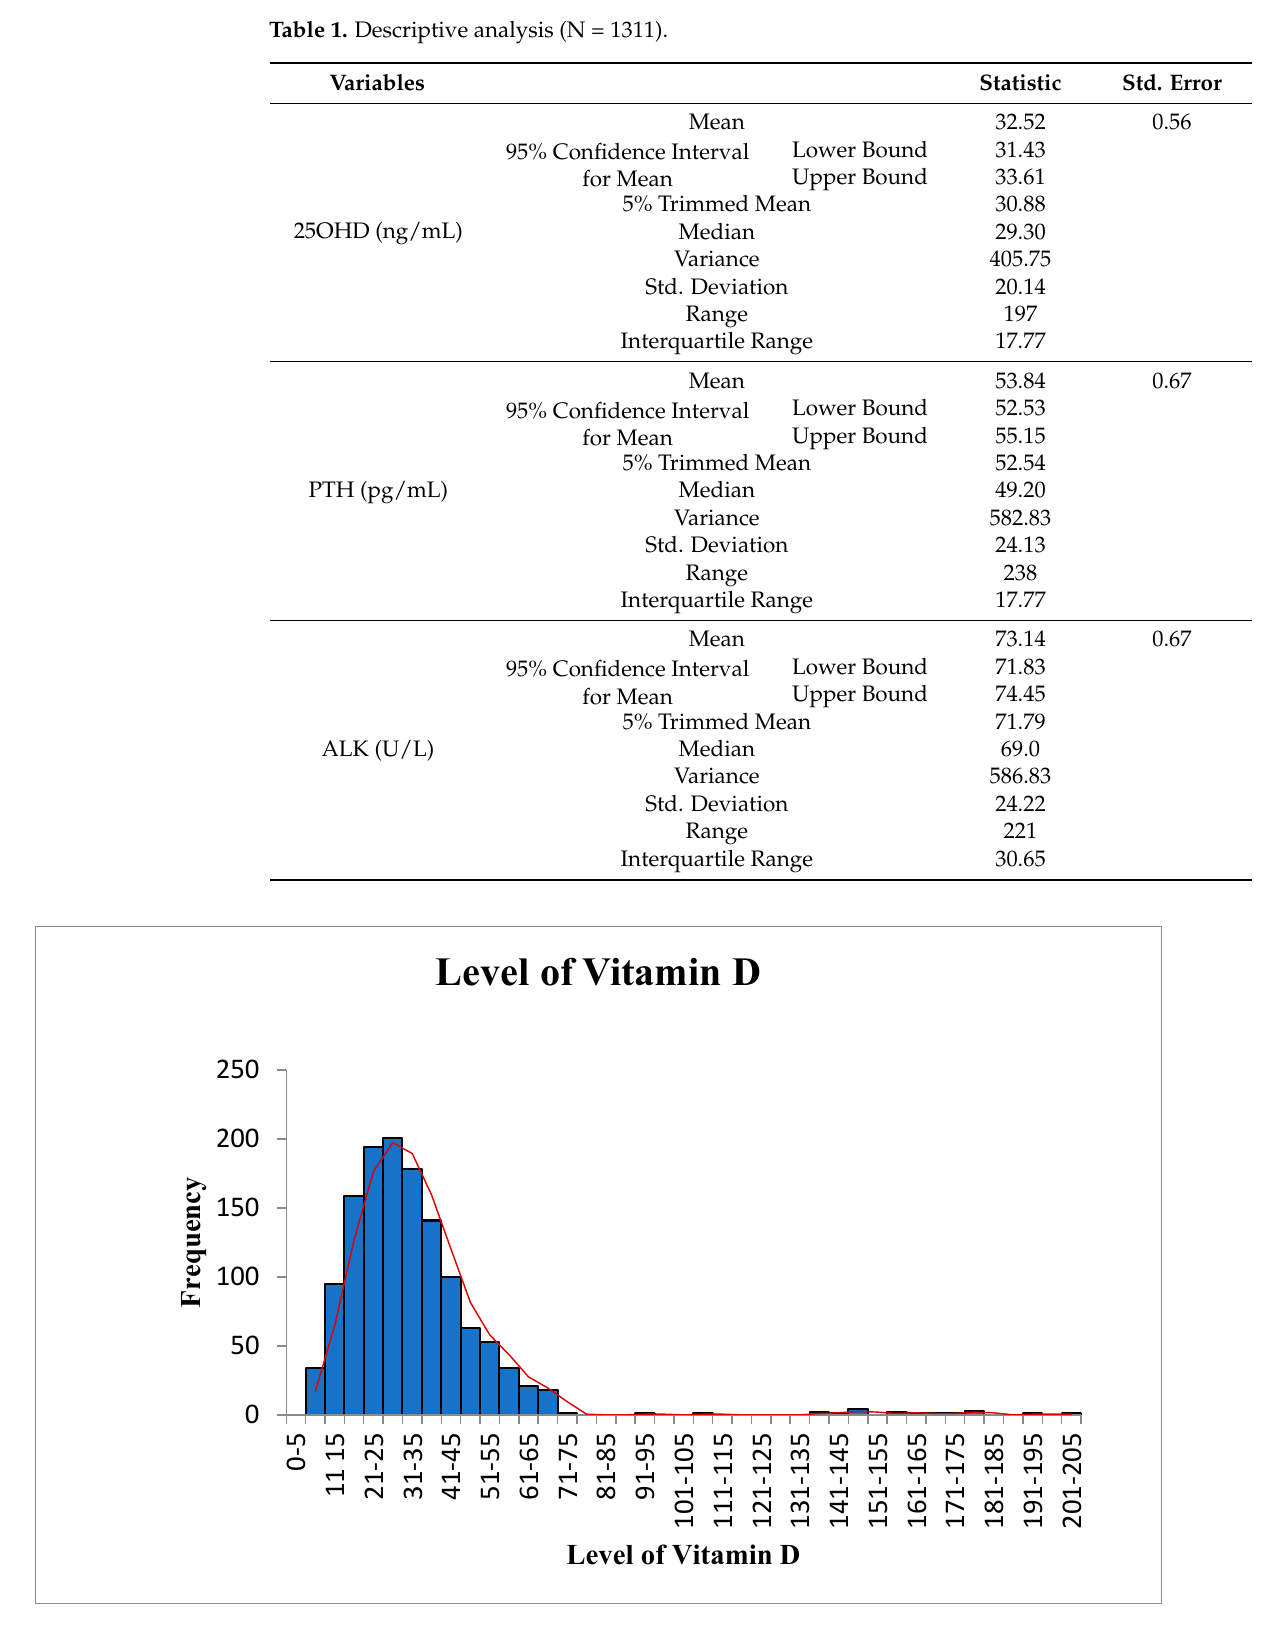
Figure 2. Parathyroid hormone level.